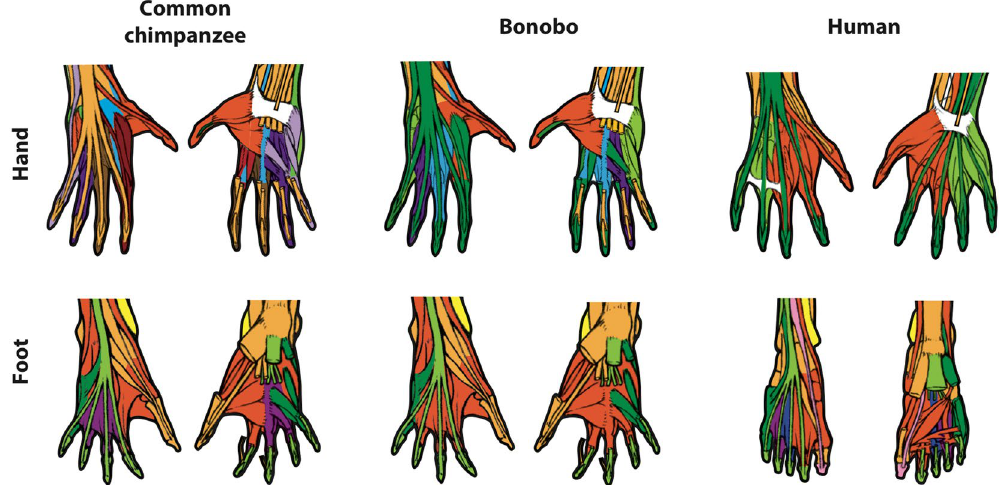
Figure 3. Details of hindlimb and forelimb autopod anatomical network modules of common chimpanzees, bonobos and humans. For more details and for names and specific composition of each module, see captions of Figs 1 and 2, text and SI1; for a list of all musculoskeletal structures and their connections, see